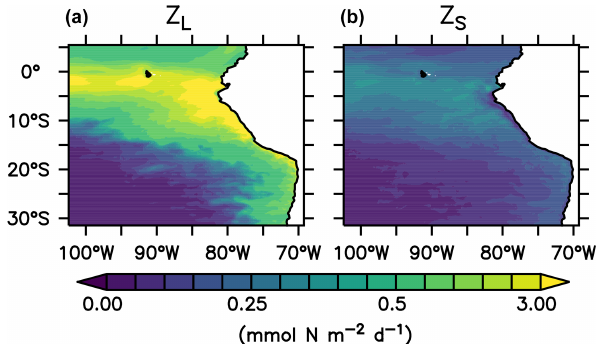
Figure 3. Nitrogen flux from large (a) and small (b) zooplank- ton to detritus due to zooplankton mortality, integrated over the upper 100m of the water column in the reference scenario (mmolNm − 2 d − 1